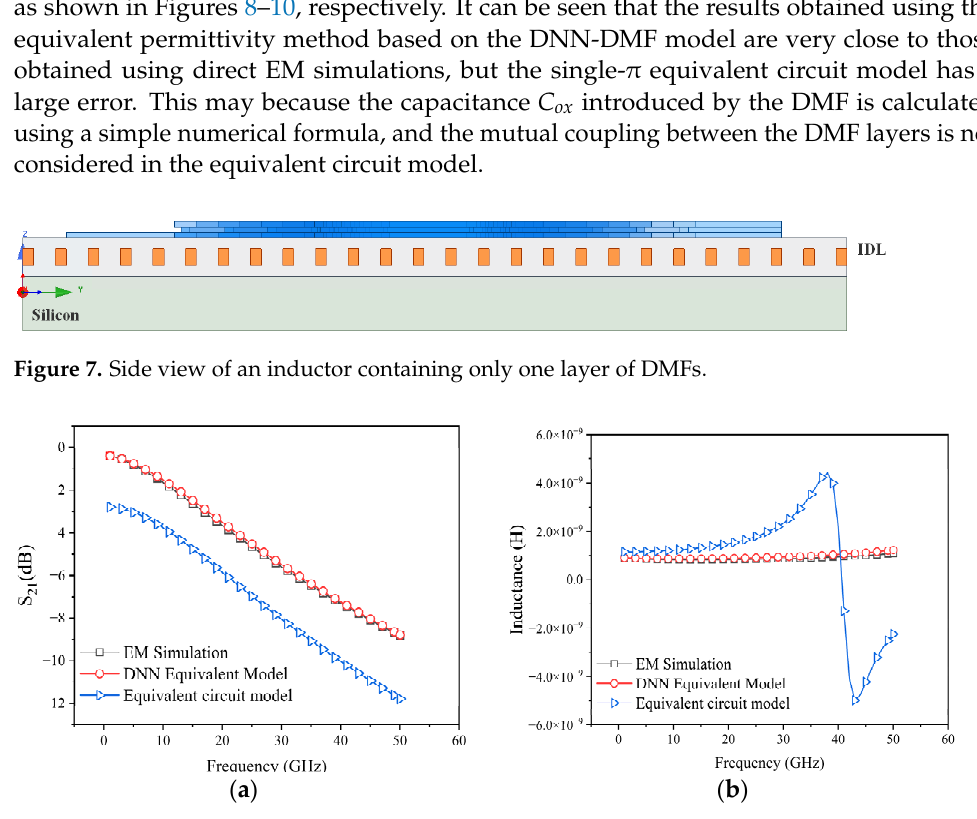
Figure 8. S-parameters (S 21 ) and inductance values for a metal filling density of 20%; ( a ) shows S-parameters (S 21 ) and ( b ) shows inductance values.